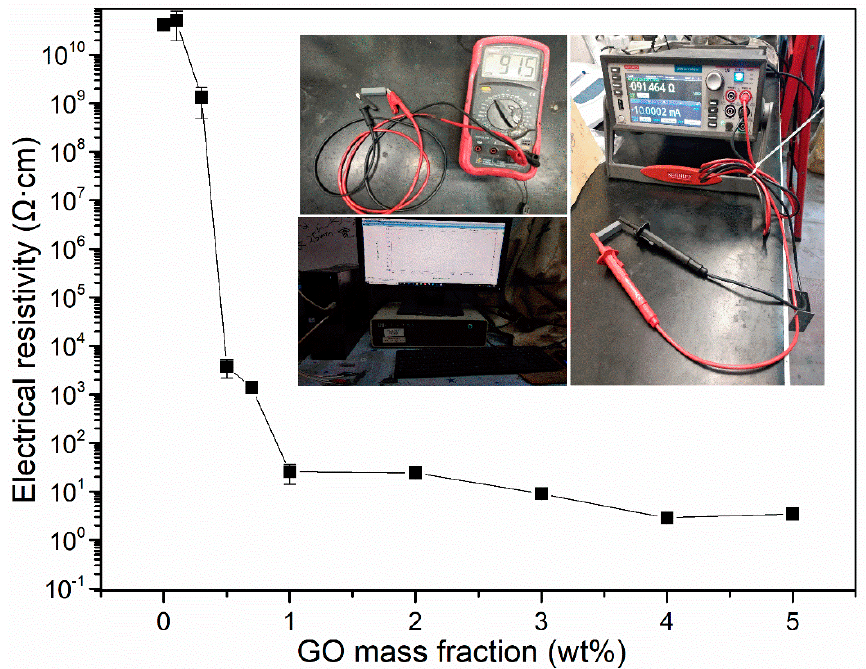
Figure 6. Electrical resistivity of CGCB with different GO contents.